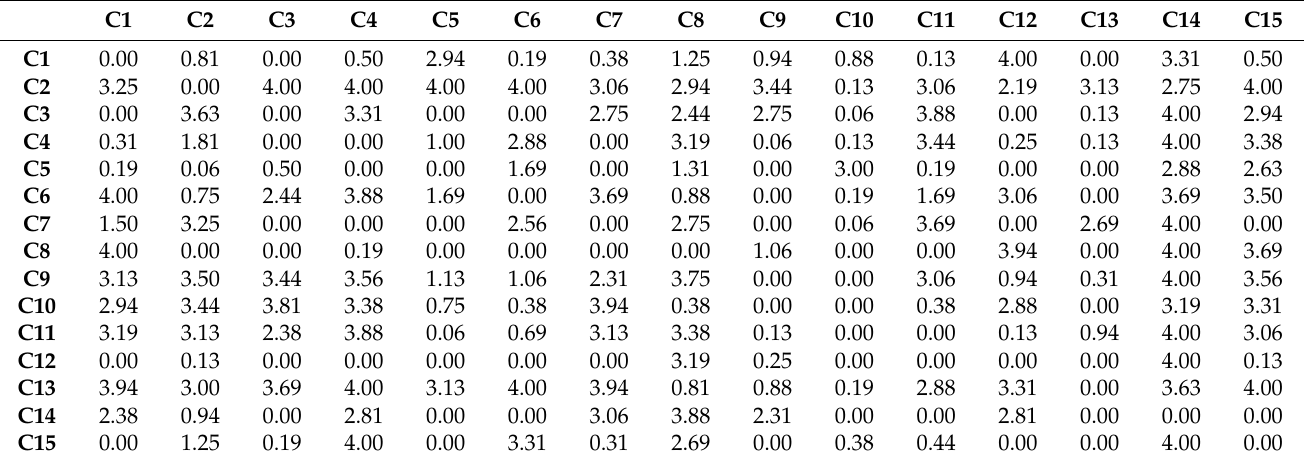
Table 4. Direct-relation